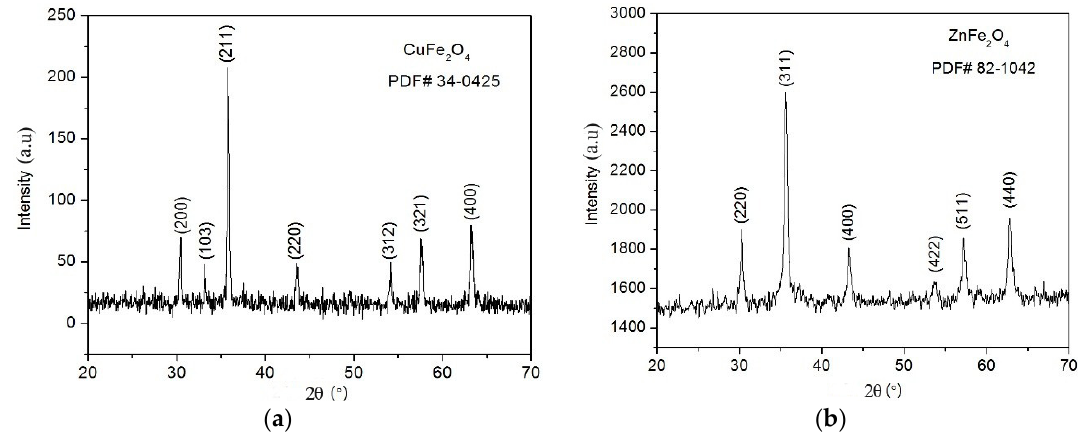
Figure 1. ( a ) X ‐ Ray Diffraction (XRD) pattern of the CuFe 2 O 4 nanopowder; ( b ) XRD pattern of the ZnFe 2 O 4 nanopowder.